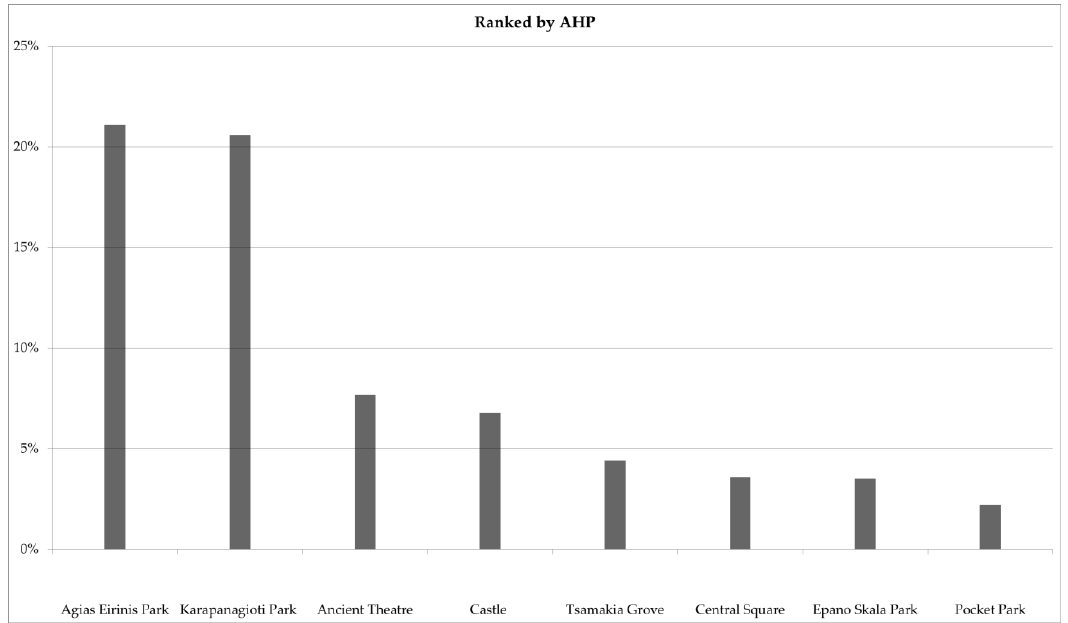
Figure 6. The potential quiet areas in order based on the results of the Analytical Hierarchy Process conducted (Matsinos et al., 2017).